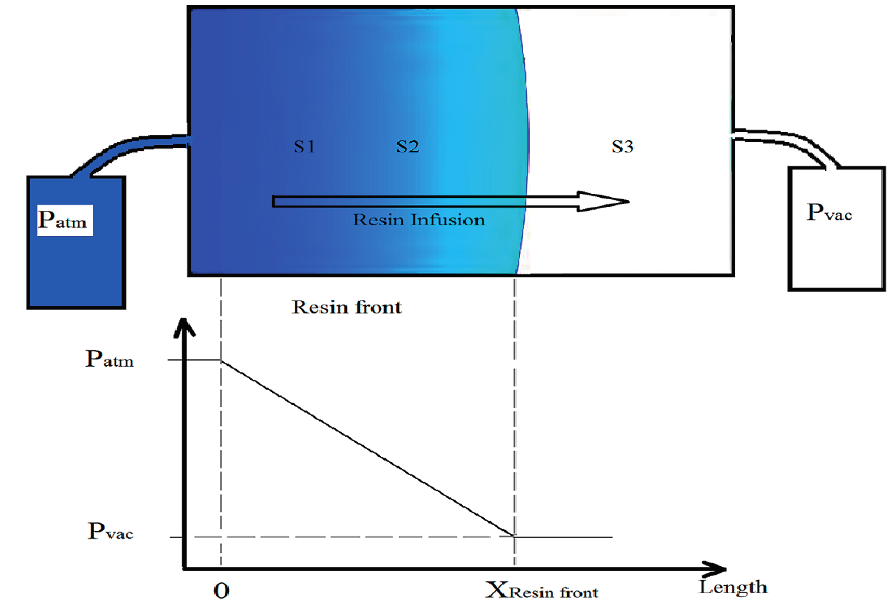
Figure 8. Pressure gradient between the infusion line and the vacuum line in the laminate.